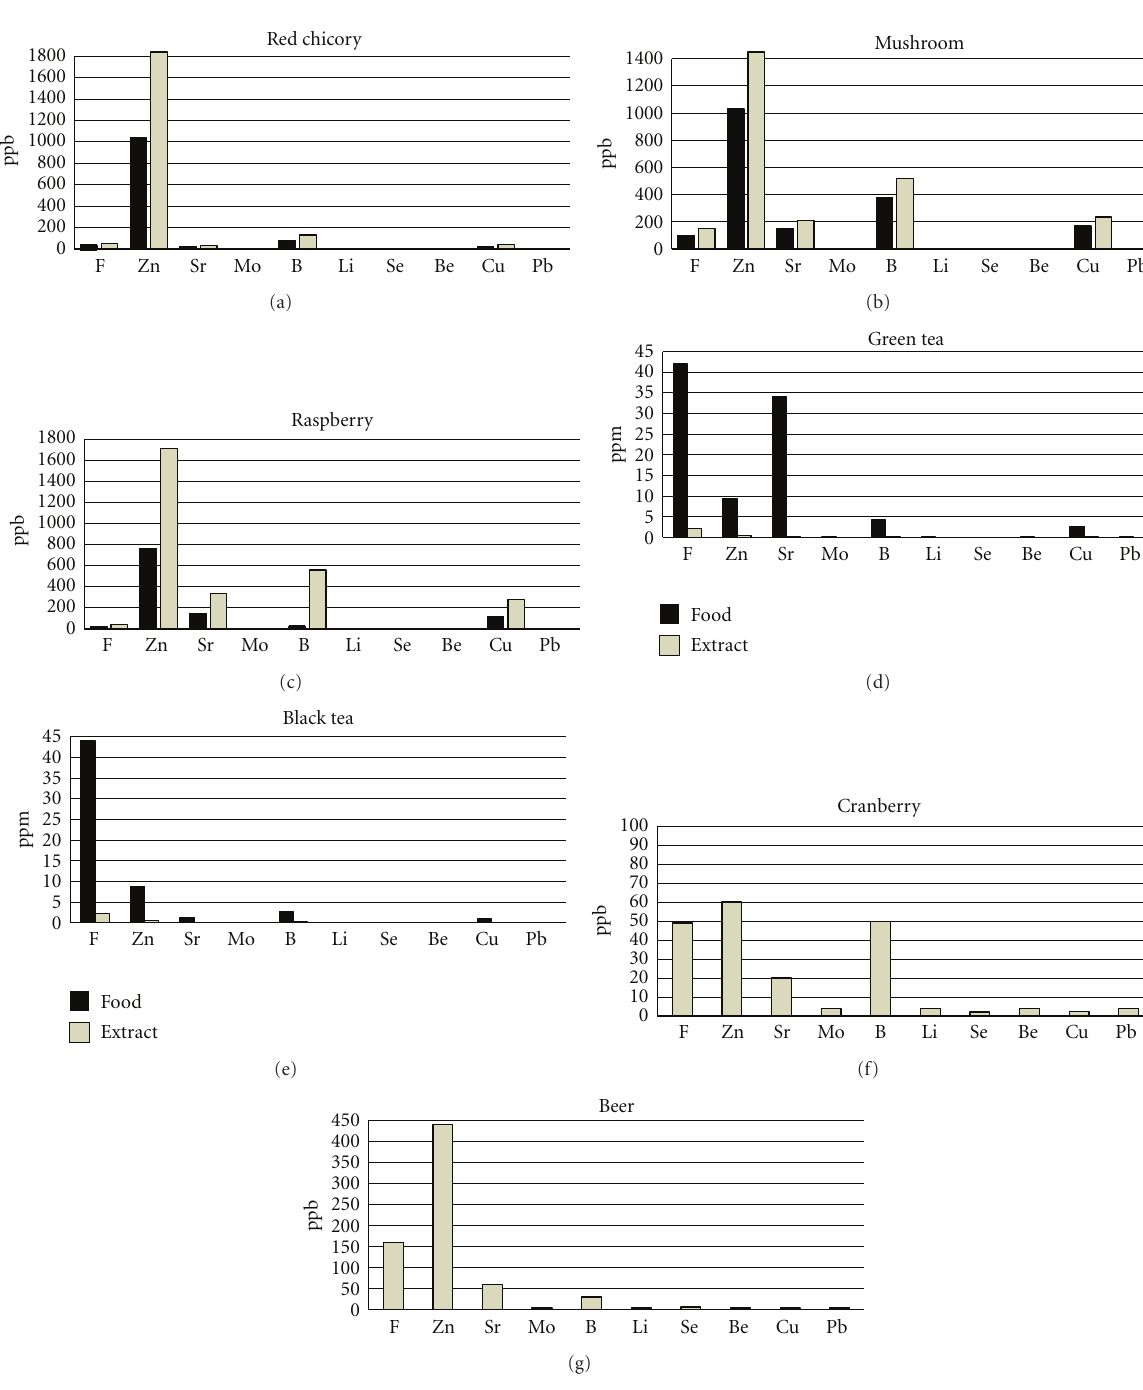
Figure 1: Mineral content of food/beverages and their extracts (espressed in ppm or